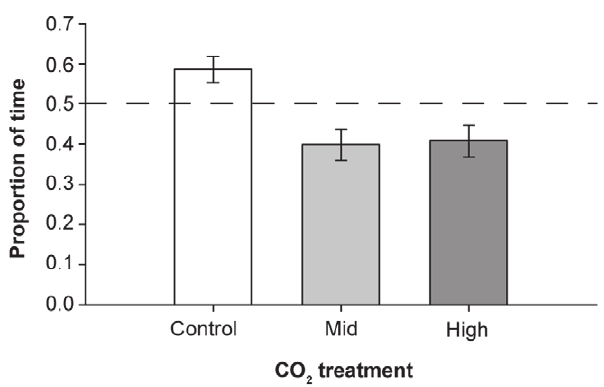
Figure 1. Response of Pseudochromis fuscus to prey skin extracts. Proportion of time (mean 6 SE) spent in the channel receiving the prey skin extracts for P. fuscus exposed to control (n=10), mid CO 2 (n=10) and high CO 2 (n=14) water treatments. Letters above bars indicate post-hoc Tukey’s HSD groupings of means at p ,